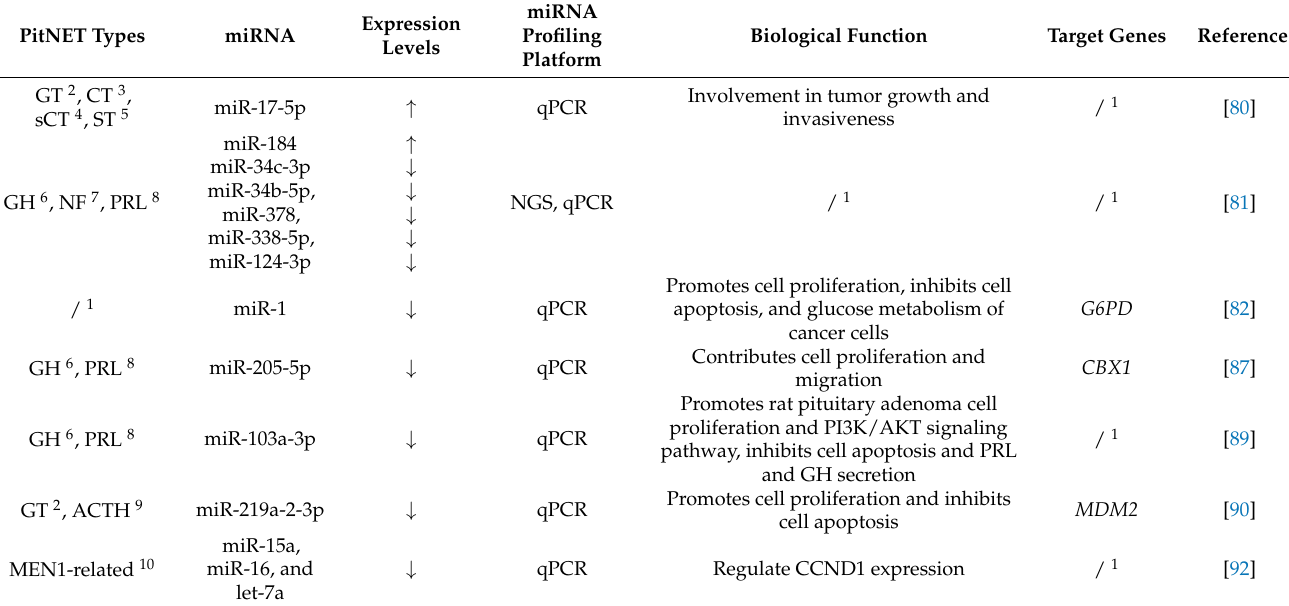
Table 7. Summary of differentially expressed miRNAs with their validated targets in a variety of pituitary tumors. PitNET